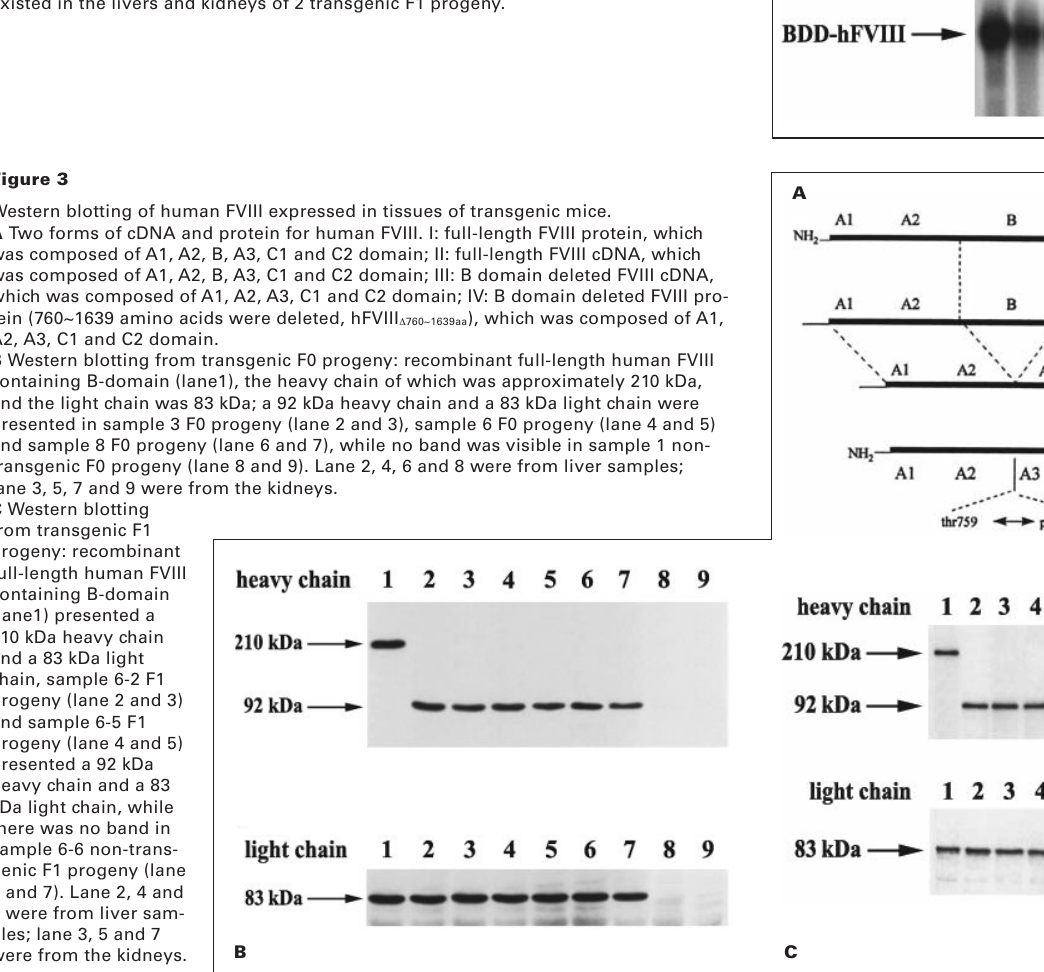
Northern blotting of BDD-hFVIIImRNA in tissues of transgenic mice. A Northern blotting from transgenic samples 3 F0 progeny (lane 1 and 2), 6 F0 prog- eny (lane 3 and 4), 8 F0 progeny (lane 5 and 6) and 1 non-transgenic F0 progeny (lane 7 and 8). Lane 1, 3, 5 and 7 were from liver samples; lane 2, 4, 6 and 8 were from the kidneys.Ten micrograms of RNA per lane were run onto a 1% formaldehyde agarose gel, blotted, and hybridized with the BDD- hFVIII cDNA probe. BDD- hFVIII mRNA existed in the livers and kidneys of 3 transgenic F0 progeny (lane 1-6). B Northern blotting from transgenic samples 6-2 F1 progeny (lane 1 and 2), 6-5 F1 progeny (lane 3 and 4) and 6-6 non-transgenic F1 progeny (lane 5 and 6). Lane 1, 3 and 5 were from liver samples; lane 2, 4 and 6 were from the kidneys. BDD- hFVIII mRNA existed in the livers and kidneys of 2 transgenic F1